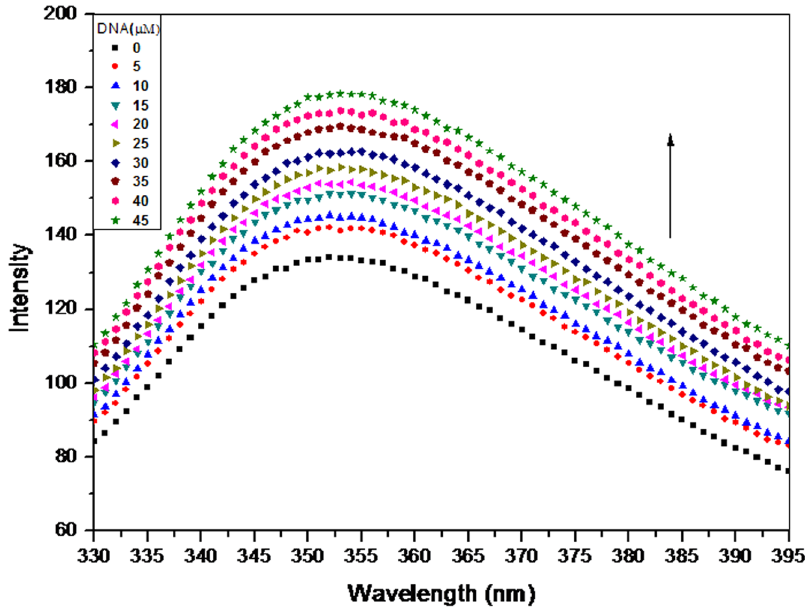
Figure 2. Interaction of 6MP with CT-DNA studied using fluorescence spectroscopy. Fluorescence emission spectra of 6MP (50 m M) in the presence of increasing concentrations of CT-DNA. Increase in the fluorescent intensity was observed with increasing DNA concentration. Excitation wavelength was 280 nm and emission was recorded as shown in figure.